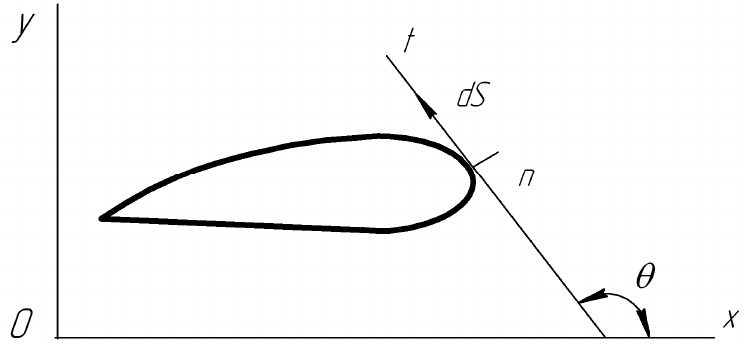
Figure 3. Boundary conditions for the vehicle’s contour.